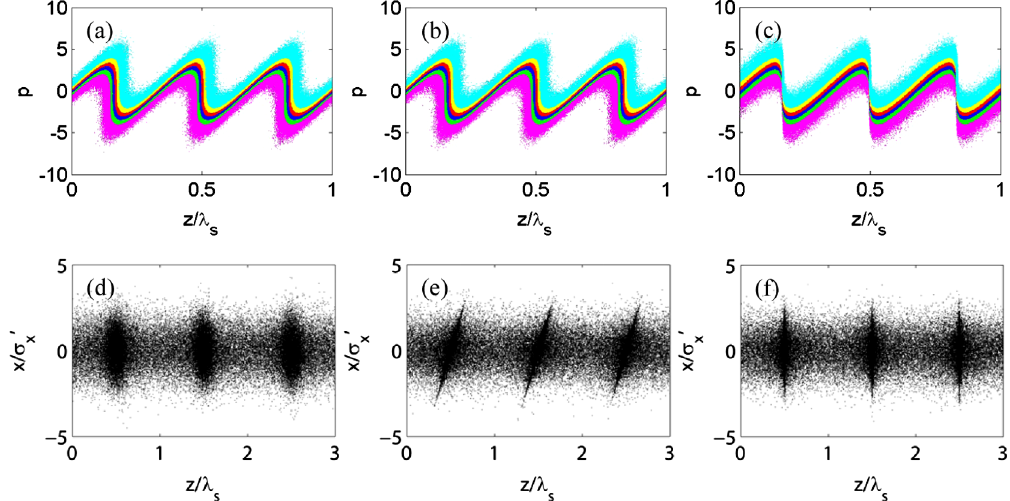
SXFEL.FIG. 2. Comparison of beam longitudinal phase space ( p - z ) and normalized transverse electrons distributions ( x - z ) for different electron and laser beam injection